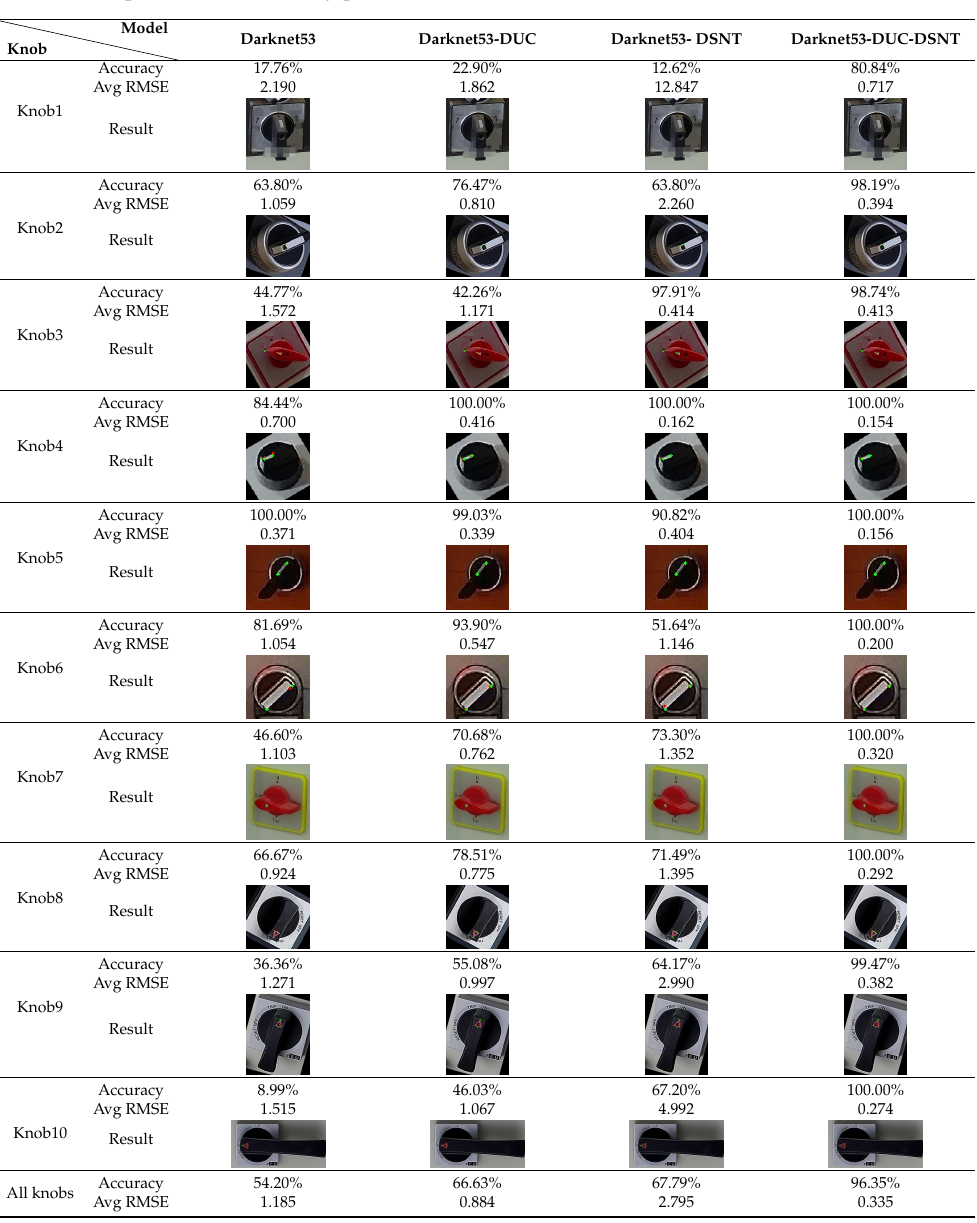
Table 4. Comparison results of key point detection